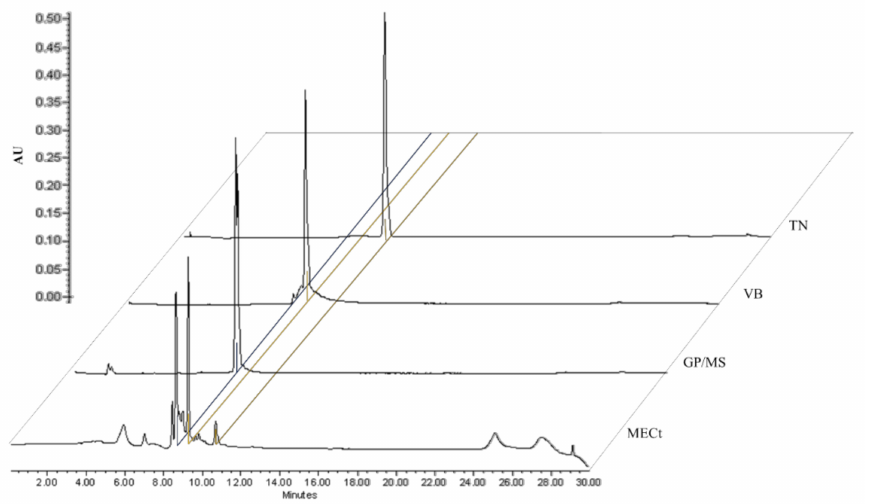
Figure 2. Chemical profiles of methanol extract (MECt), mixture of geniposide/mussaenoside ( GP / MS , 8.3 min), verbascoside ( VB , 9.15 min) and tenuifloroside ( TN , 10.6 min). Chromatograms were developed at the UV wavelength of 240, 330 and 280 nm. Table 1. Chemical content of GP / MS , VB and TN in each treatment from Castilleja tenuiflora Benth. Doses